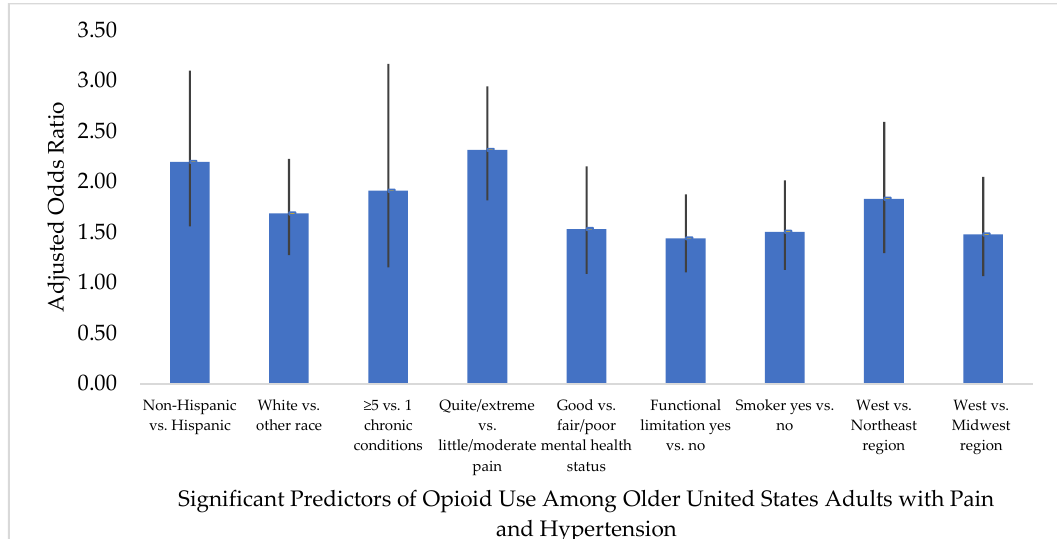
Figure 1. Predictive characteristics of opioid medication use among older United States adults (age ≥50 years) with pain in the past four weeks and a diagnosis of hypertension. Pain–hypertension group: unweighted sample n = 2733 (opioid use n = 803; no opioid use n = 1930) reflects weighted sample n = 29,308,898 (opioid users n = 8,625,387; non-users n = 20,683,511) of United States adults alive during the calendar year 2017, age ≥ 50 years, with self-reported pain in the past four weeks, and a diagnosis of hypertension. “No opioid use” served as the reference group for the dependent variable in the binomial logistic regression. Only characteristics that were significant predictors of opioid use are included in the figure.